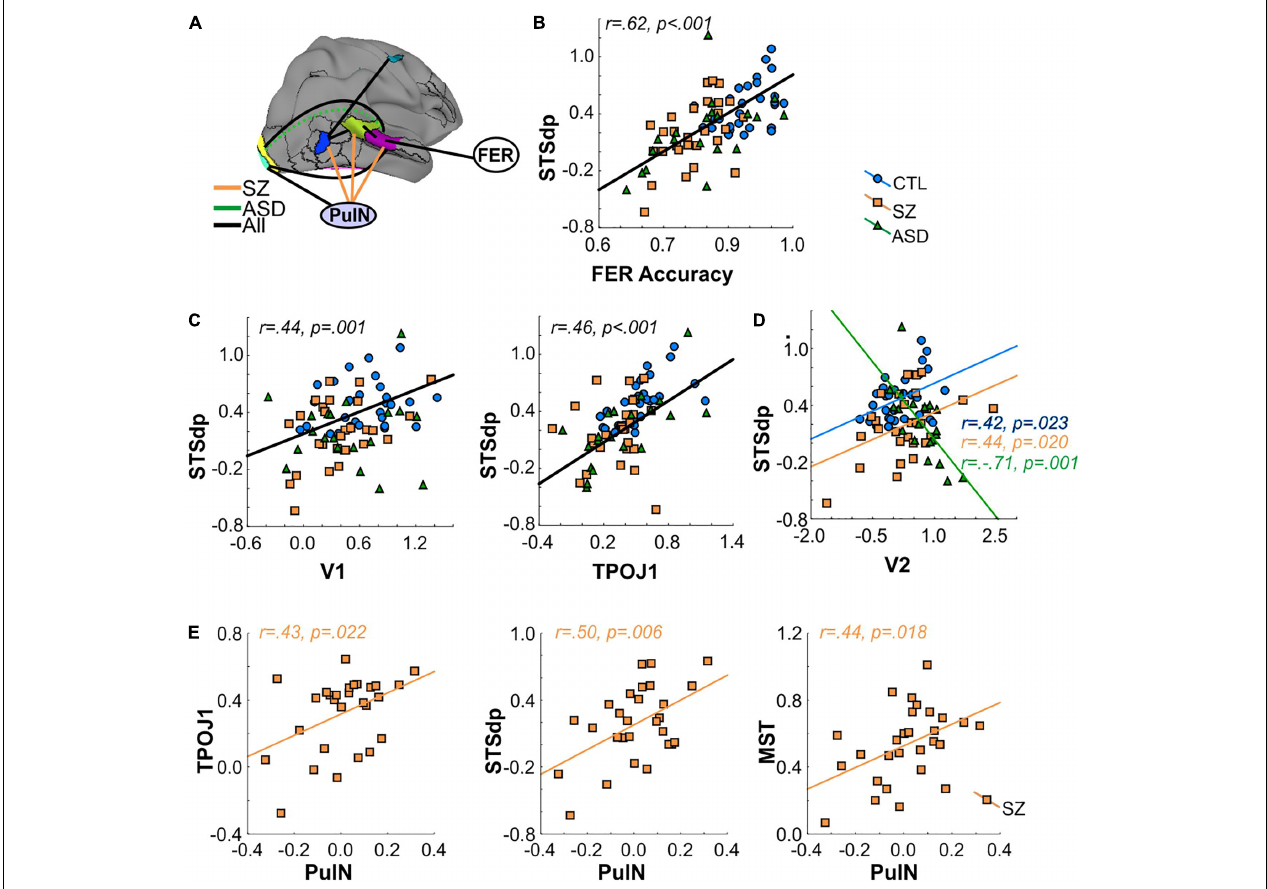
FIGURE 5 | (A) Interrelationship between activated cortical regions, pulvinar (PulN) activation and face-emotion recognition (FER) accuracy. Black lines denote a significant relationship across all groups. Orange lines denote significant relationship only in SZ group. Dashed green line denotes a significant (negative) correlation in ASD group only. (B) Correlation between FER accuracy and mean activation (beta) of the STSdp parcel. In all cases, black regression lines signify the correlation was significant across groups. (C) Correlation between STSdp-V1 and STSdp-TPOJ1 activation. (D) Correlation between STSdp-V2 activation. In ASD participants, enhanced V2 was associated with reduced STSdp activation. The opposite relationship was obtained in SZ and CTL groups. (E) Scatterplots showing a significant and positive correlation between PulN activation and TPOJ1 (left), STSdp (center) and MST (right) in the SZ group